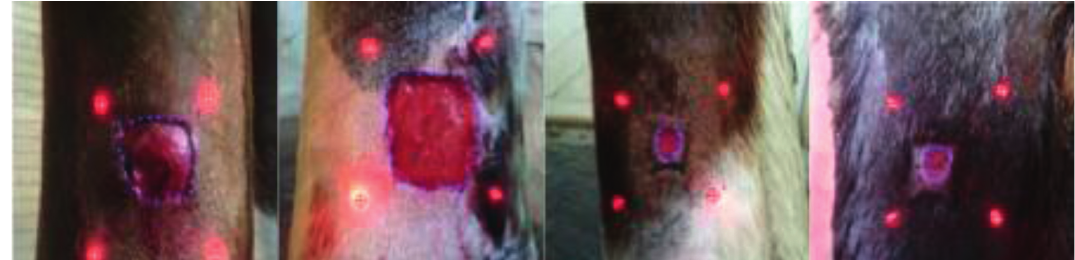
Figure 4: Digital image. The laser beams projected by the camera on the wound surface (red) draw a square shape allowing the clinician to delineate a precise wound perimeter (blue) and the software to calculate a surface area. This figure shows four types of wounds at different stages of the healing